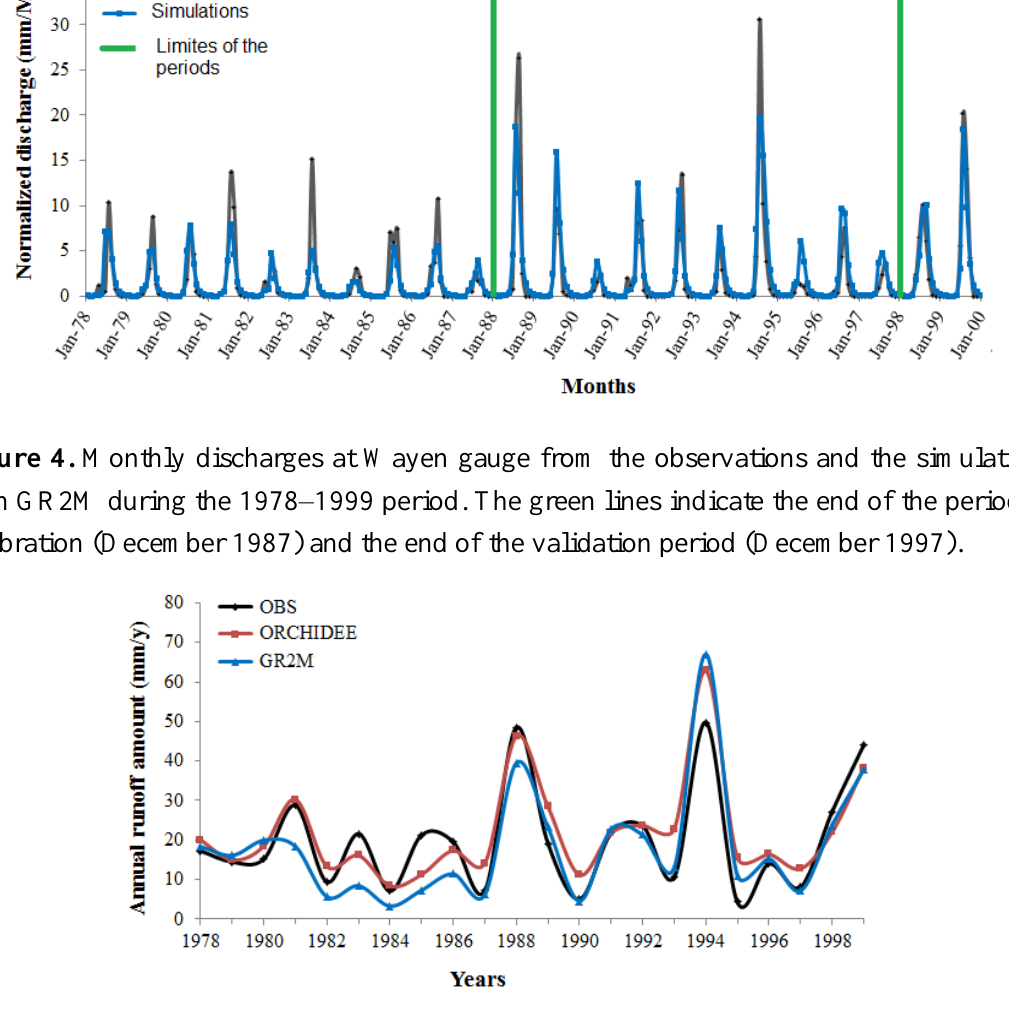
Figure 5. Annual runoff amount simulated by two models (GR2M and ORCHIDEE) and the observations at Wayen gauge over the 1978–1999